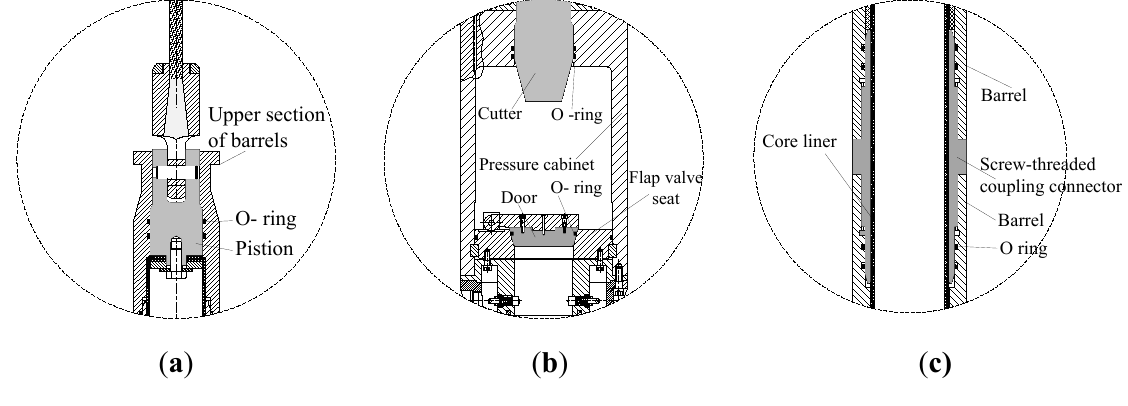
Figure 3. Four key sealing structures: ( a ) When the piston is pulled up by the winch wire to the end of the upper section of the core barrels, there are two O-rings to keep the seawater in the core from leaking out; ( b ) There are two seals, and when the core cutter is lifted up to the end of the center hole, there are two O-rings in case of leakage. When the door is turned to the conical opening of the flap valve seat, there is also an O-ring between them; and ( c ) at both sides of the screw-threaded coupling sleeve, there are two smooth guide pipe segments, the two O-rings seal the smooth guide pipe segments and the core